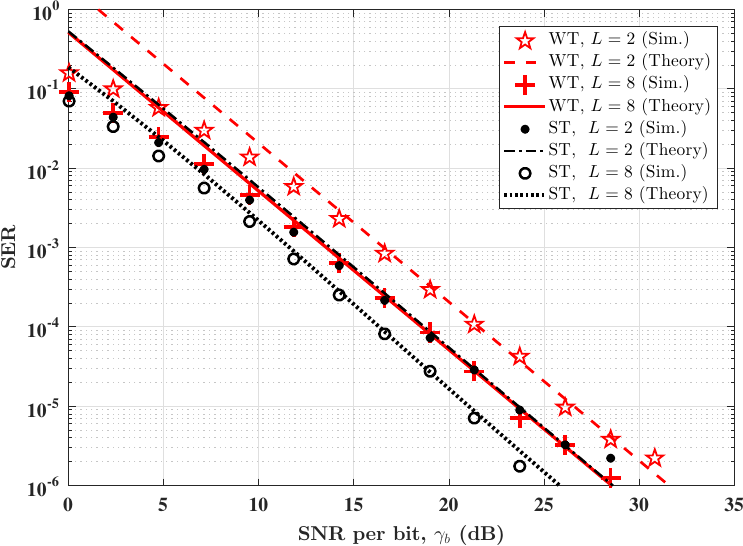
Figure 2. Error performance of SPPM in weak and strong atmospheric turbulence (AT) conditions. N t = 2, N r = 4, and L =[ 2,8 ] . ST, strong AT; WT, weak AT; SER, symbol error